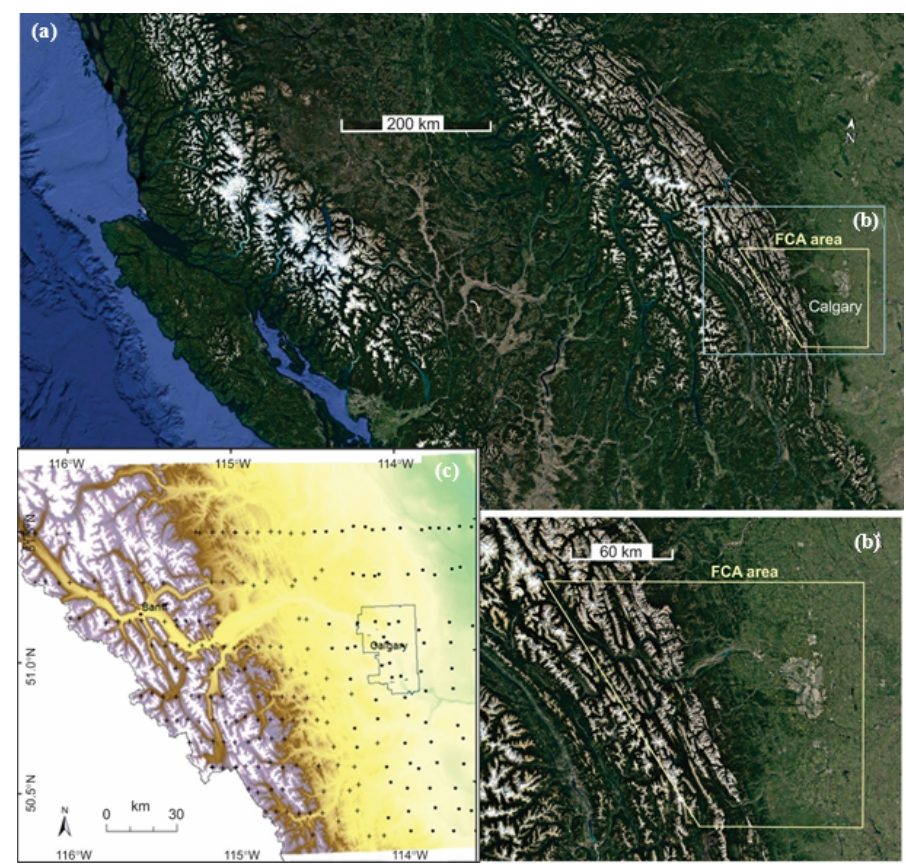
Figure 1. Foothills Climate Array (FCA) study region. (a) Location within southwestern Canada, with the blue inset indicating (b) the study setting within the regional context of the Canadian Rocky Mountains and the yellow inset indicating (c) the FCA site network. Panels (a) and (b) are courtesy of Google Earth. Crosses are mountain sites and dots are prairie